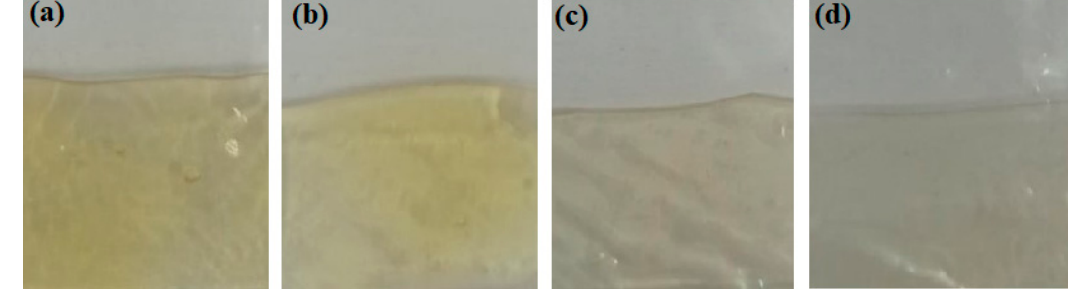
Figure 2. Copolymers of P(DMAEMA-co-MMA) ( a ) PDM1; ( b ) PDM2; ( c ) PDM3 and ( d ) PDM4.